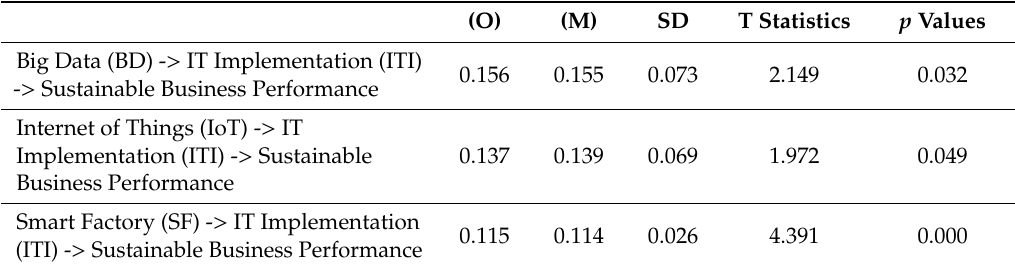
Table 7. Mediation E ff ect.